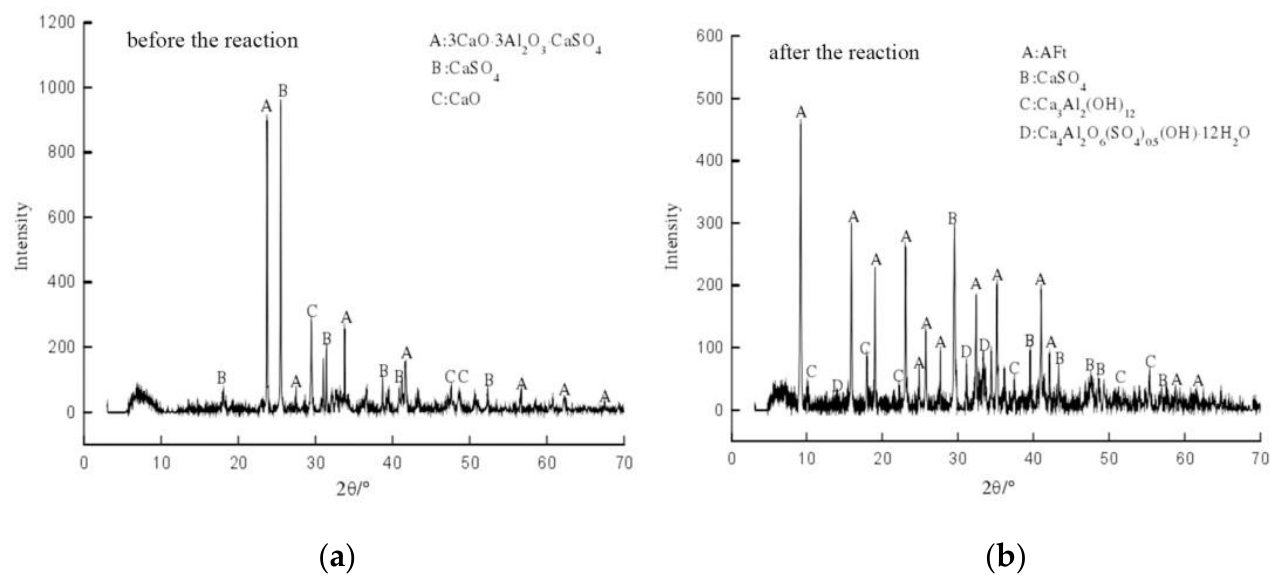
Figure 22. XRD pattern of high-water filling material before and after the hydration reaction, ( a ) before the reaction; ( b ) after the reaction [27].